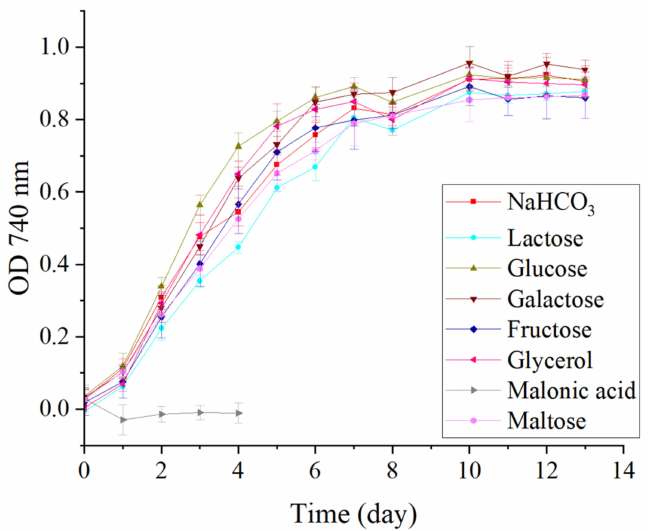
Figure 3. Growth curve of D. tertiolecta using different carbon sources in the mixotrophic